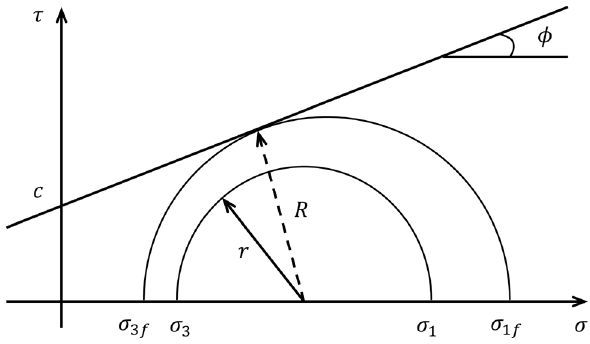
Figure 3. Criteria of strength–stress ratio.